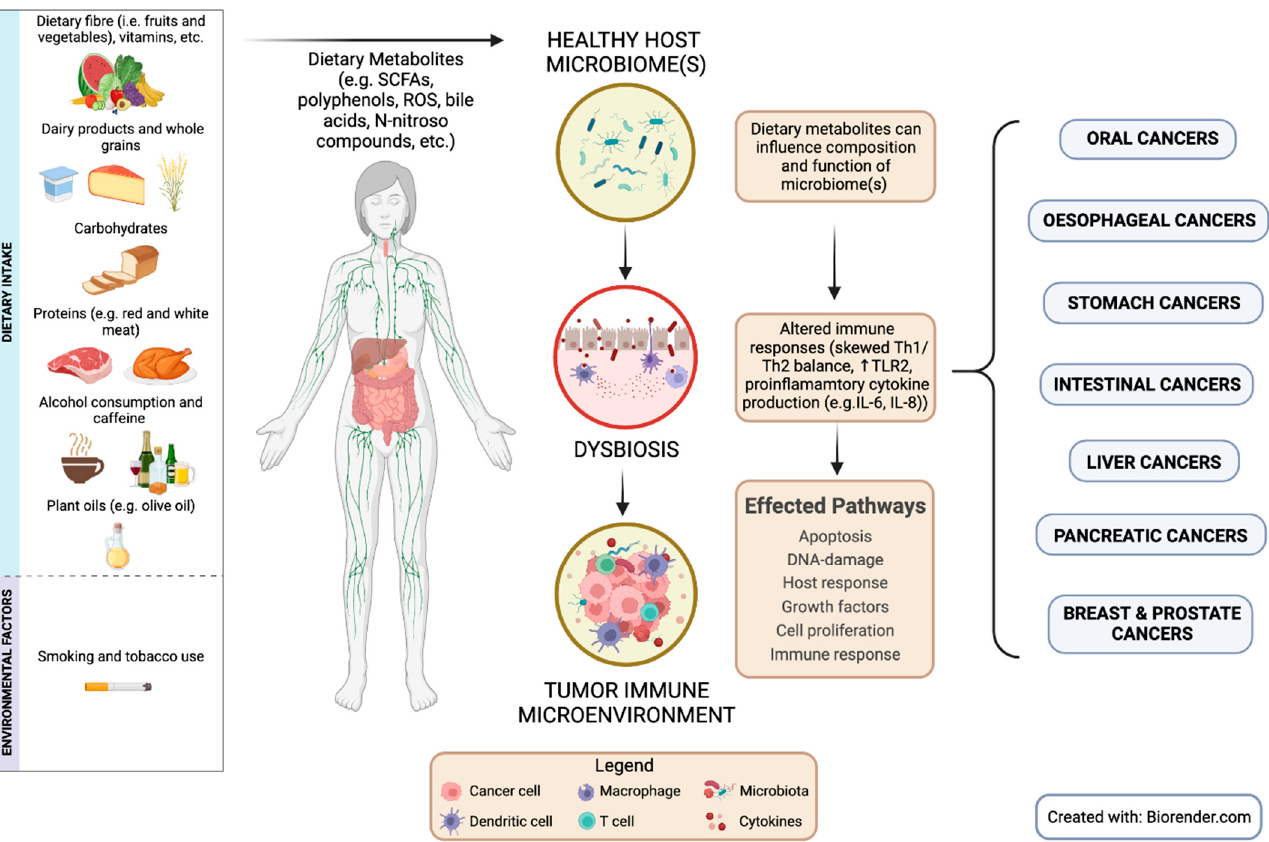
Figure 2. Host microbiomes influence different cancer pathologies via their effects on dietary factors and subsequent immunomodulatory pathways.